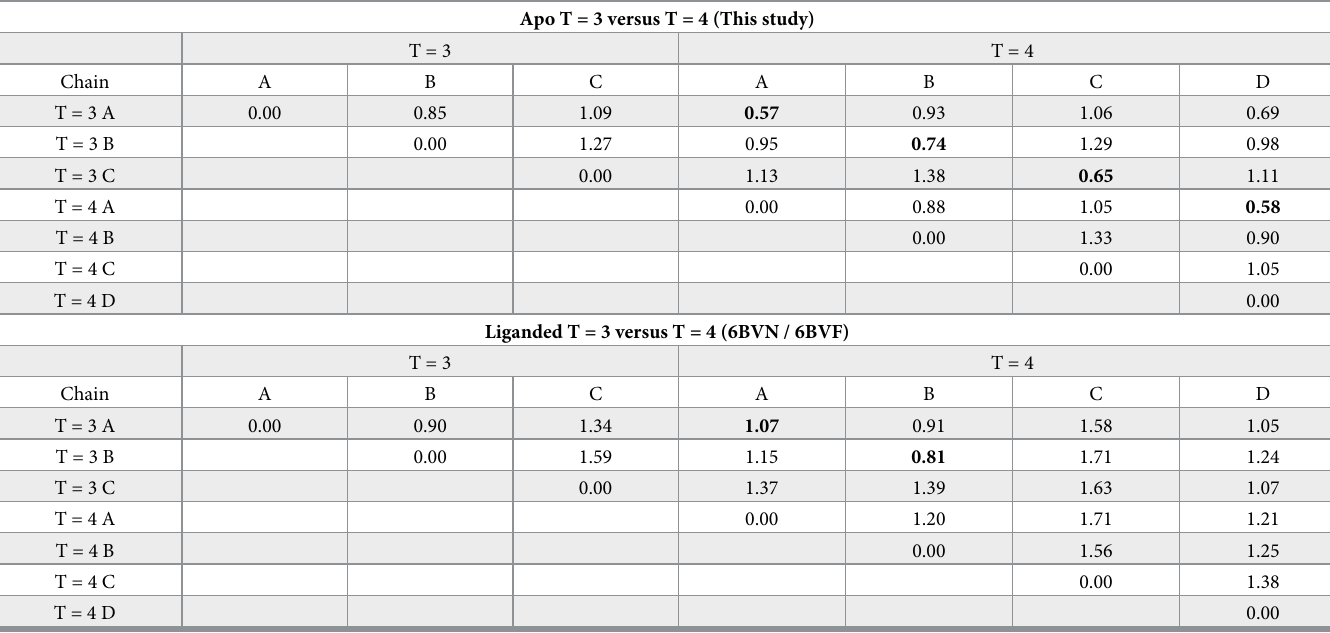
Table 2. All-atom RMSD ( Å ) of chain pairs in apo and liganded T = 3 and T = 4 capsids 1 .